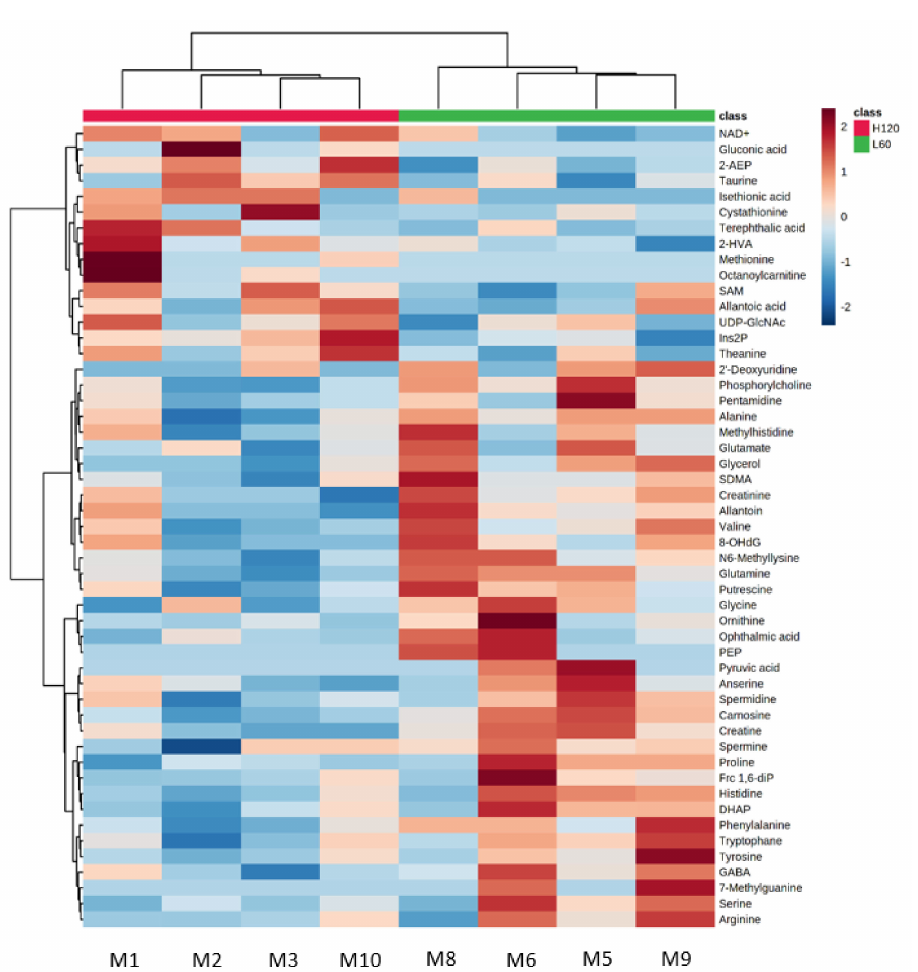
Figure 1. HCA using the top 50 statistically different metabolites between LN (green) and HN (red) fetuses. The row displays the metabolite and the column represents the sample. Metabolites with rela- tively low contents are displayed in blue, while metabolites with relatively high contents are displayed in brown. The brightness of each color corresponds to the magnitude of the difference when compared with the average value. UDP-GlcNAc: uridine diphosphate N -acetylglucosamine/uridine diphos- phate N -acetylgalactosamine, 8-OHdG: 8-hydroxy-2 (cid:48) -deoxyguanosine, PEP: phosphoenolpyruvic acid, Frc 1,6-diP: fructose 1,6-diphosphate, DHAP: dihydroxyacetone